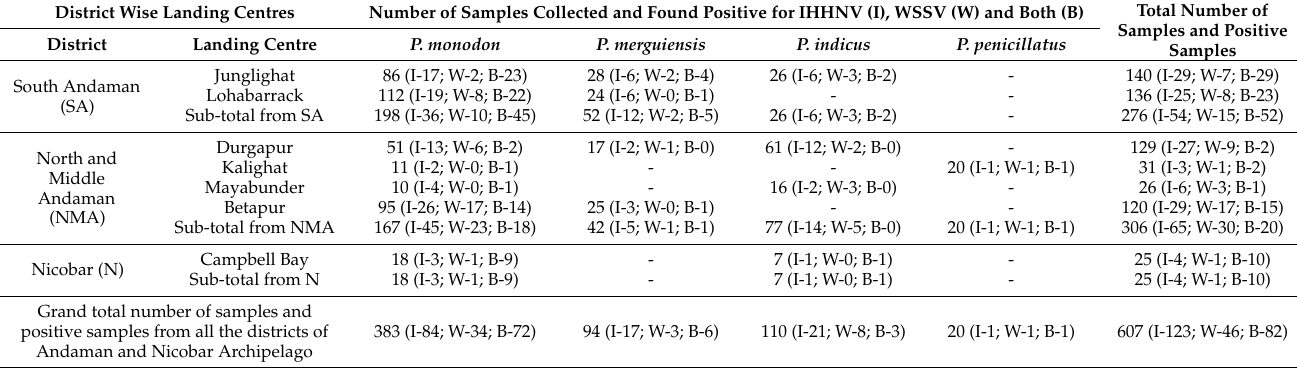
Table 1. Details of the wild shrimp samples found positive for IHHNV (I), WSSV (W) and Both (B) in Andaman and Nicobar Archipelago. Values within parenthesis indicate the number of samples found positive for IHHNV (I), WSSV (W) and Both (B) by PCR.